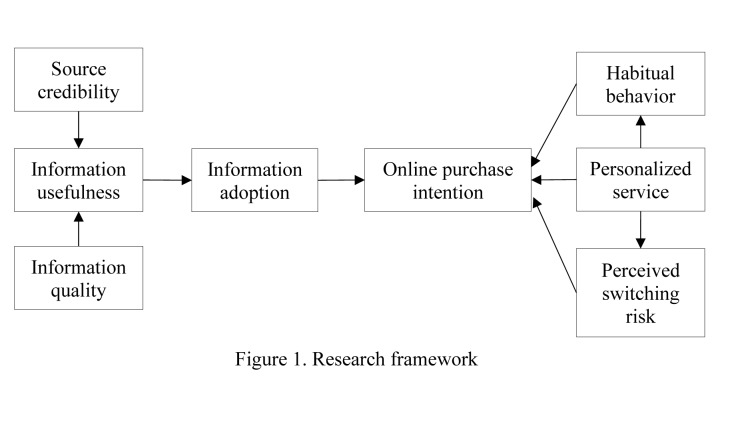
Research framework.